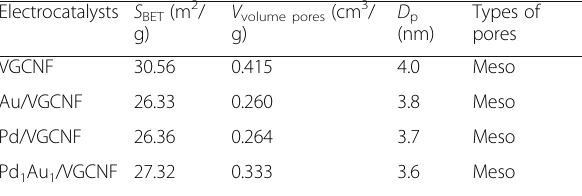
Table 1 Physicochemical parameters of electrocatalysts by BET analysis Electrocatalysts S BET (m 2 /